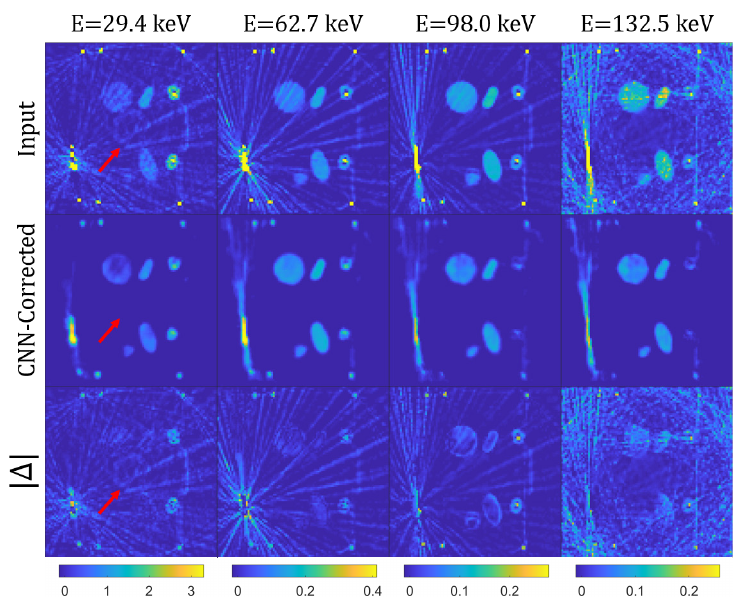
Figure 8. Slice of the suitcase for the input (first row) and CNN-corrected (second row) data at different energies and the absolute difference between the two (third row). Note that each column, corresponding to a fixed energy channel, has identical color map. The red arrow indicates a hollow object look-like artifact, which does not appear in the higher energy channel and is efficiently removed by the